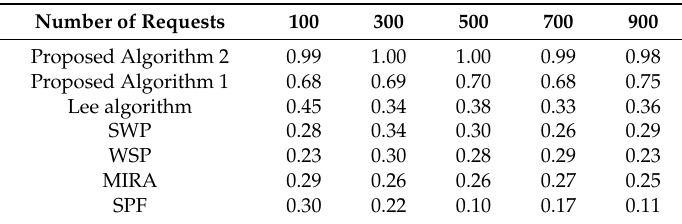
Table 4. The average value of the comprehensive evaluation path when the scheme weight W (cid:48) = [ 0.4,0.4,0.2 ]